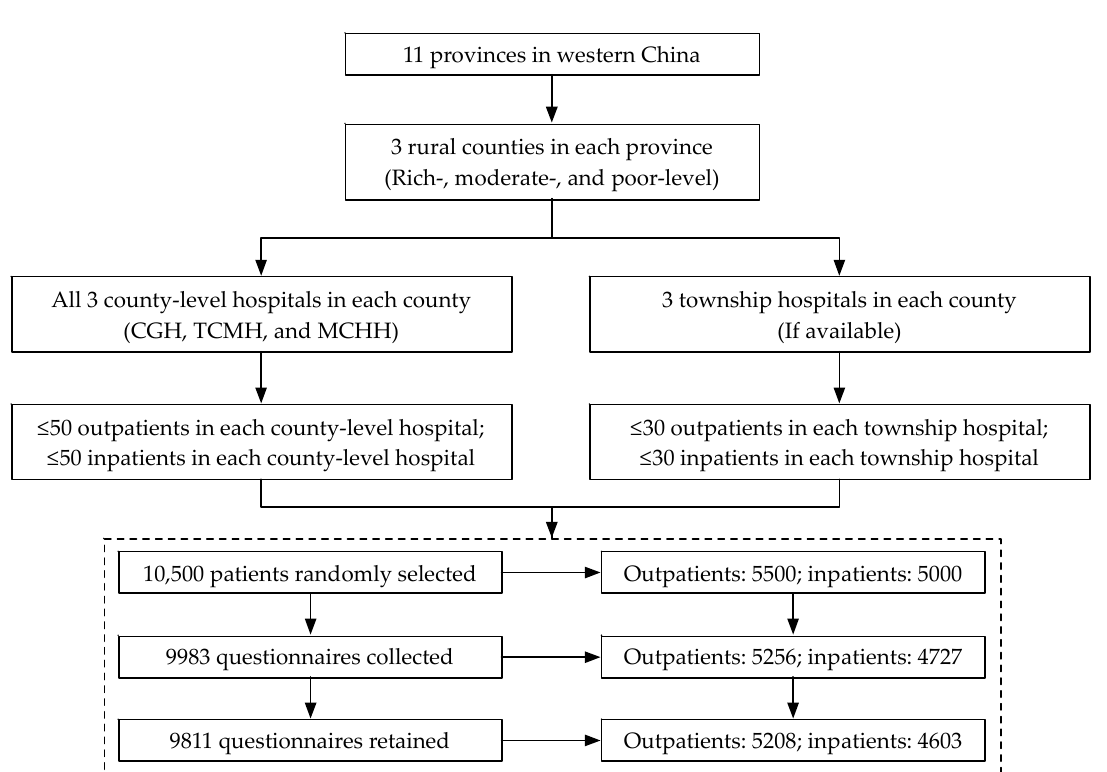
Figure 1. Sample provinces in western China.